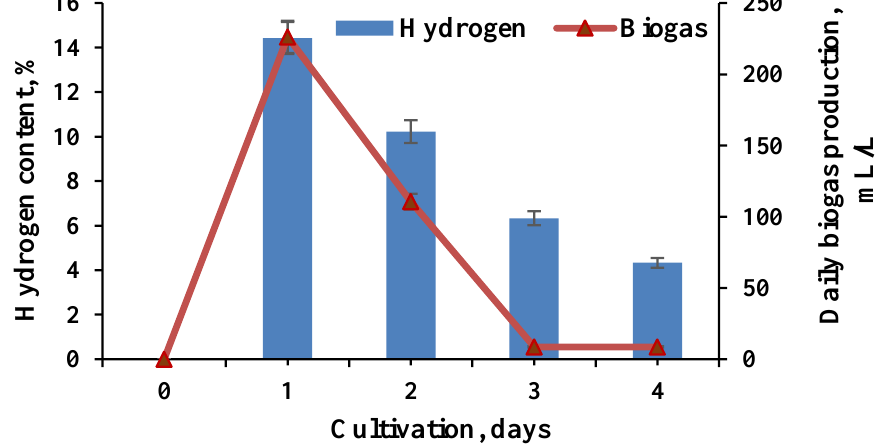
Figure 1. Dynamics of biogas (biohydrogen) production in the first BR of the cascade.